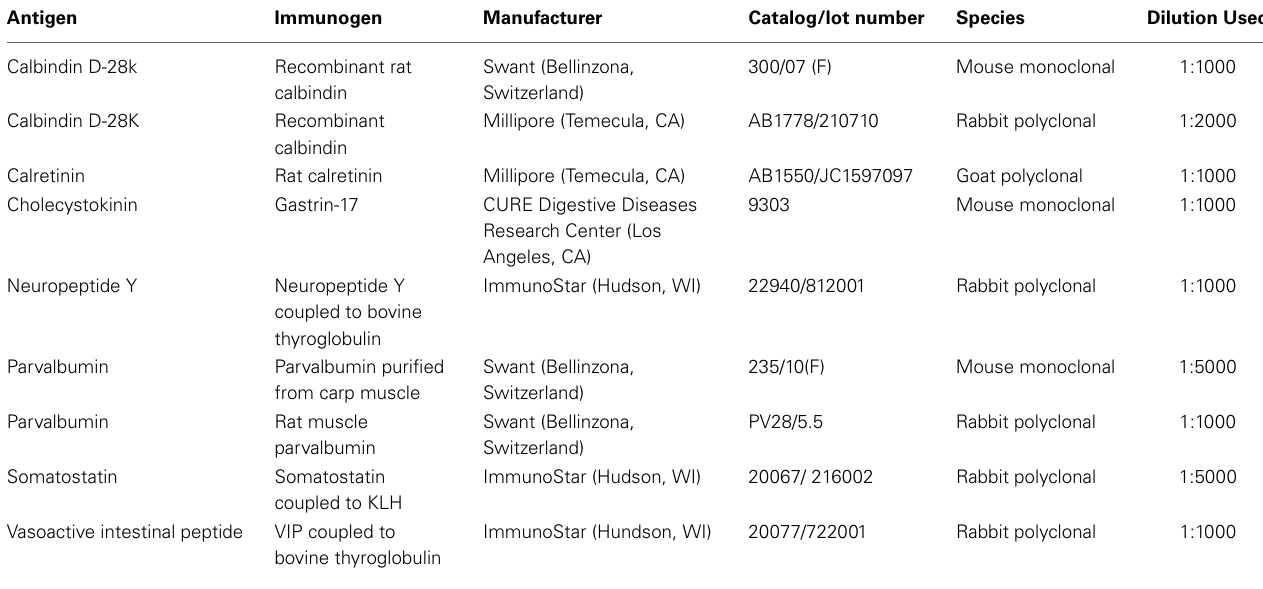
Table 1 | Primary antibodies